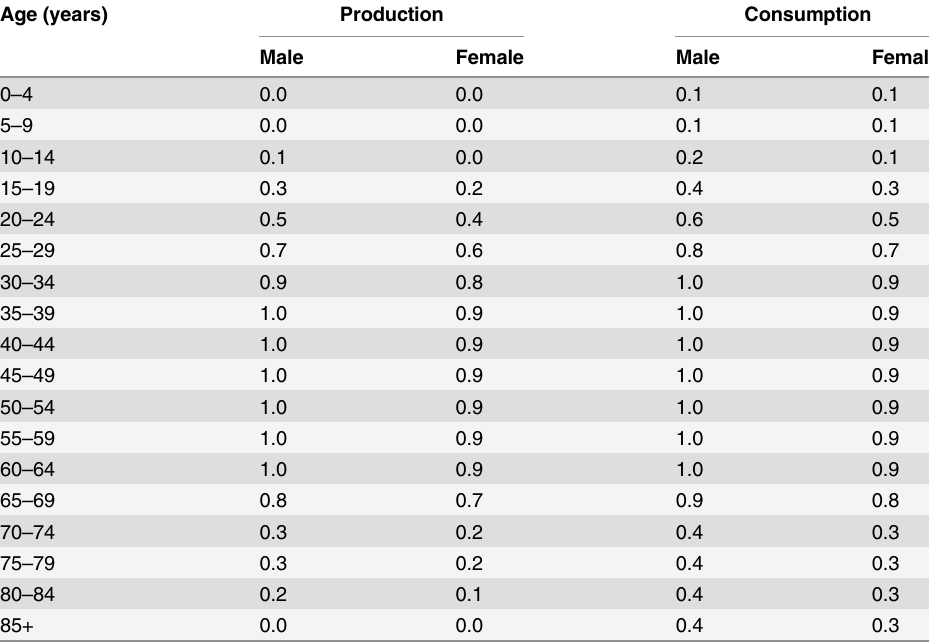
Table 2. Notional (baseline) age- and sex-speci fi c weights used to compute C and P for Na Savang households. Age